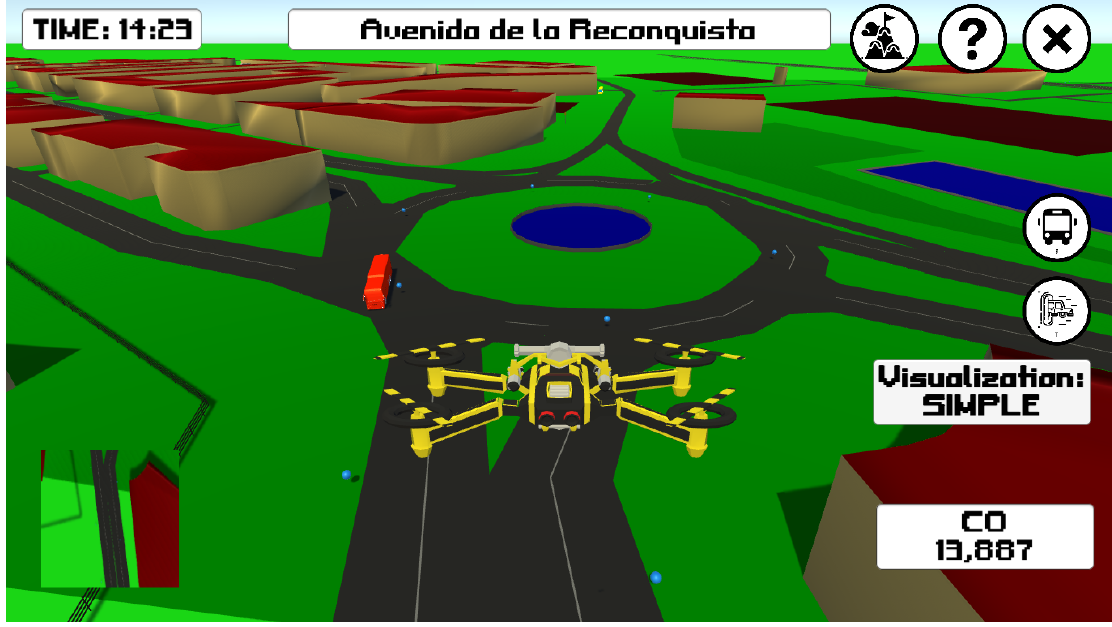
Figure 6. User view of the virtual world when controlling the virtual drone. The figure also shows an animated bus leaving the